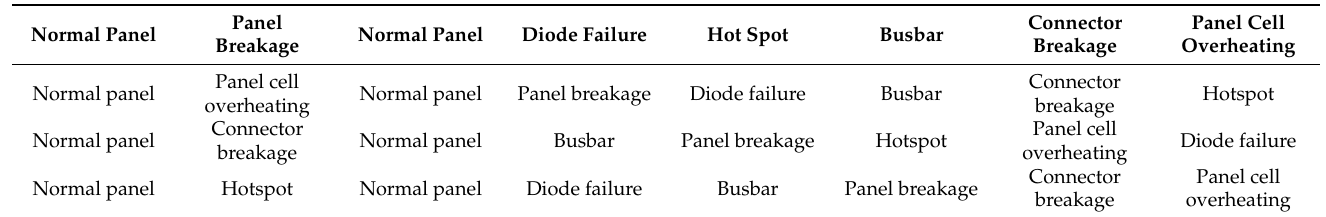
Table 4. Normal and faulty panel placement layout in the small-scale power generation facility.